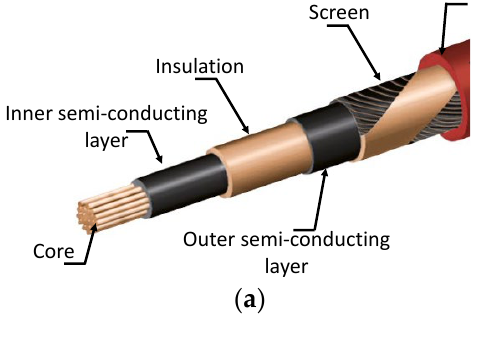
Figure 4. Defective used cable to generate PD: ( a ) layers stacking and ( b ) cross-section (indicating defect location). Table 3. Cable composition and characteristics.